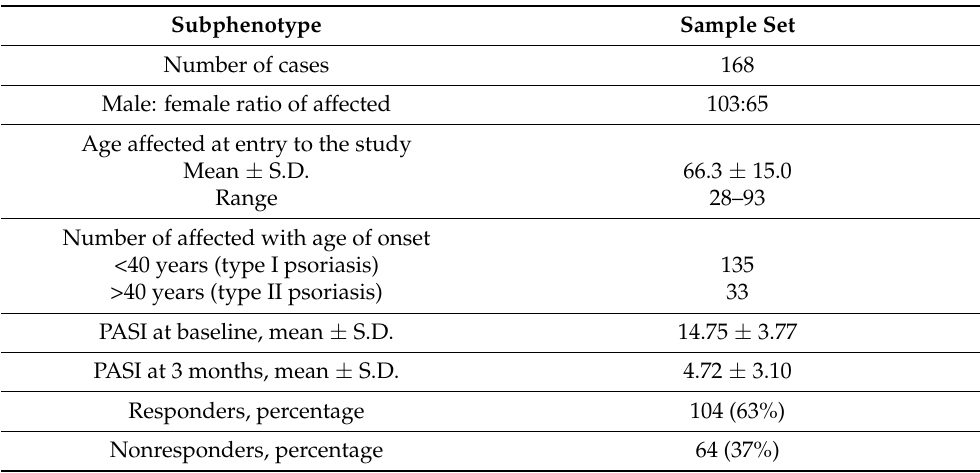
Table 1. Demographic and clinical